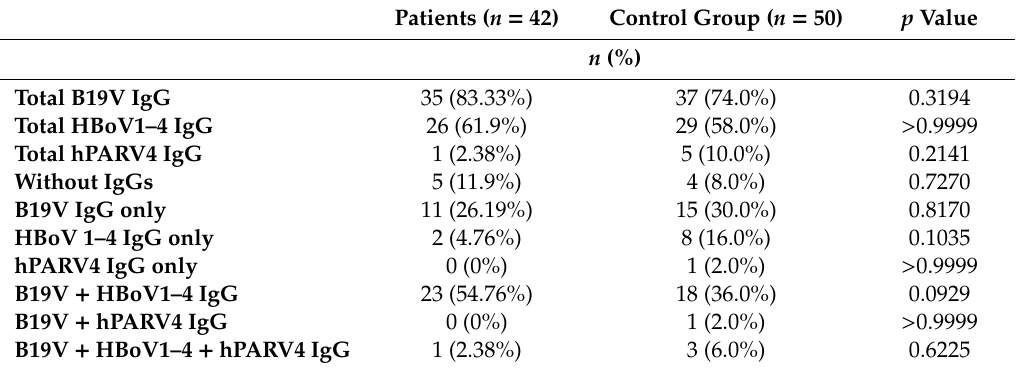
Table 1. The presence of parvovirus-specific IgG class antibodies in the patients and control